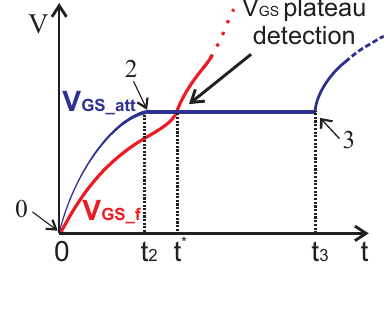
Figure 7. Principle of the detection of the gate-source